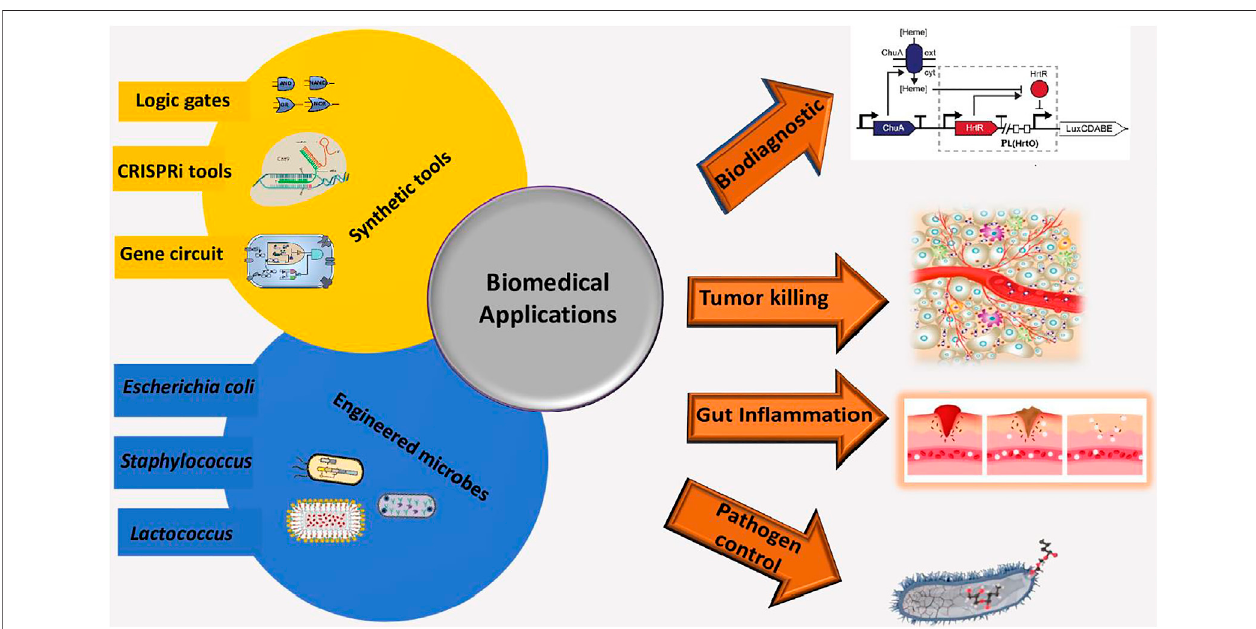
FIGURE1| Graphicalillustrationofgeneticallyengineeredmicrobesbyusingsyntheticbiologytools.Theseengineeredbacteria-basedlivingmaterialsareusedfor biodiagnostics and therapeutic purposes.